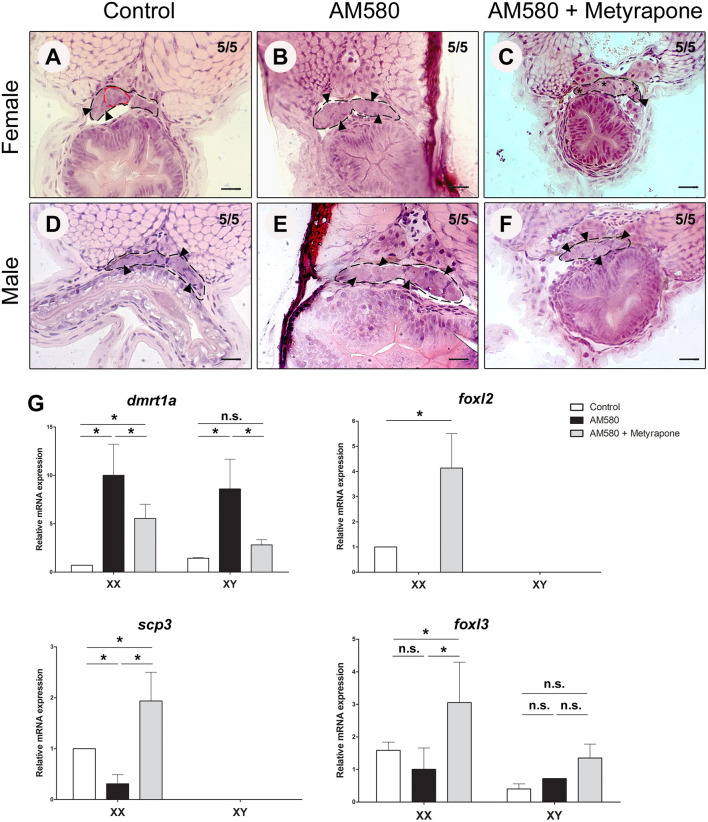
Exogenous treatment of AM580 and Metyrapone in cyp26a1–/–embryos during the sex determination period. Gonad (black dashed lines) of cyp26a1–/–female containing differentiated germ cells (red dashed lines) at 1 days after hatching (dah) in the control embryos (A). After treatments, XX embryos present only undifferentiated germ cells (arrowhead) (B). Co-treatment with AM580 and Metyrapone showed increase of early oogenesis stage germ cells (star) in females (C). No morphological differences in the gonads of XY mutants were observed in the control (D) and in treated embryos with AM580 (E) and both AM580 and Metyrapone (F), all containing only undifferentiated germ cells (arrowhead) Scale bar = 20 μm. Expression of dmrt1a, foxl2, foxl3, and scp3 in cyp26a1–/–embryos after treatment with AM580 and Metyrapone. After Student's t-test (p < 0.05), significant (asterisk) and not significant (n.s.) expression differences were observed between control and treatment groups (G).